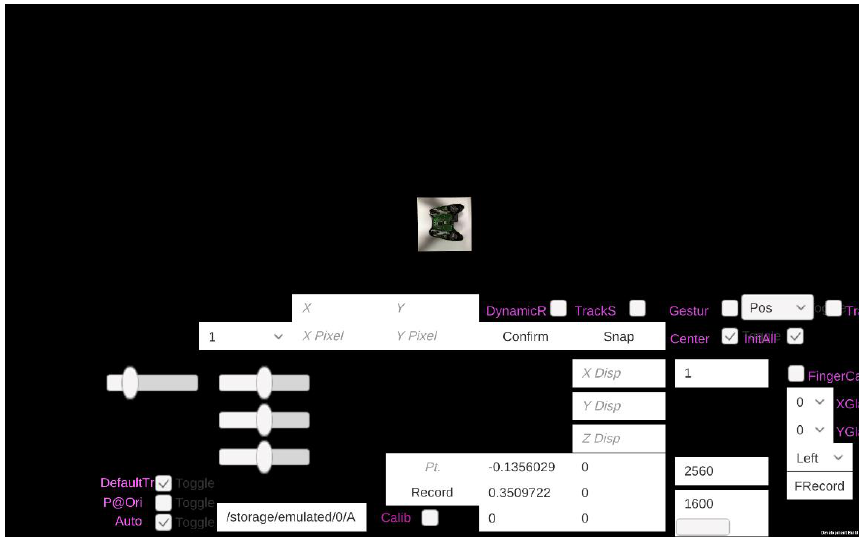
Figure 6. Custom User Interface.